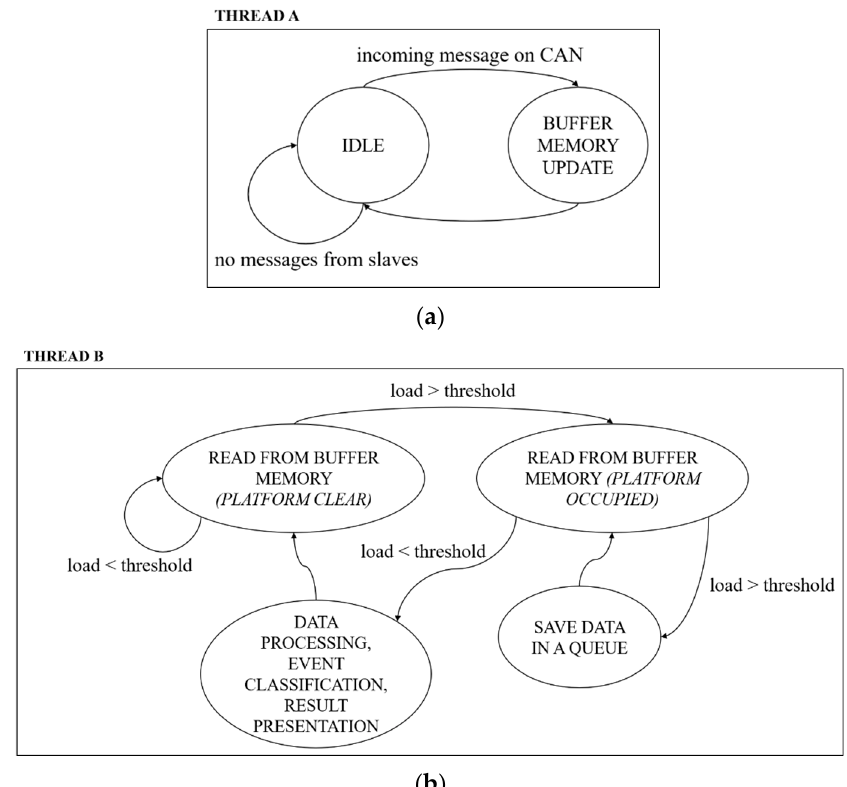
Figure 16. Master software architecture: ( a ) thread A, ( b ) thread B.